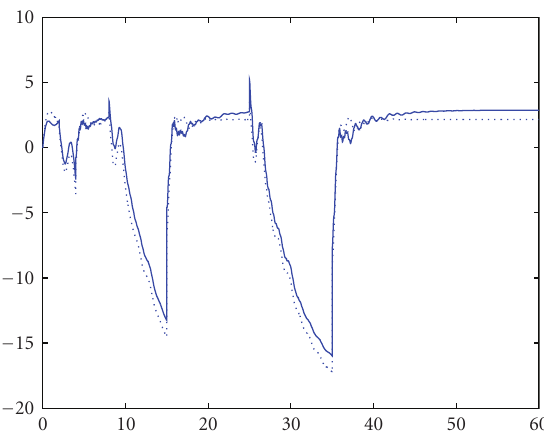
Figure 8: Step response of original switched linear system (solid line) and the reduced-order model which is of order 17